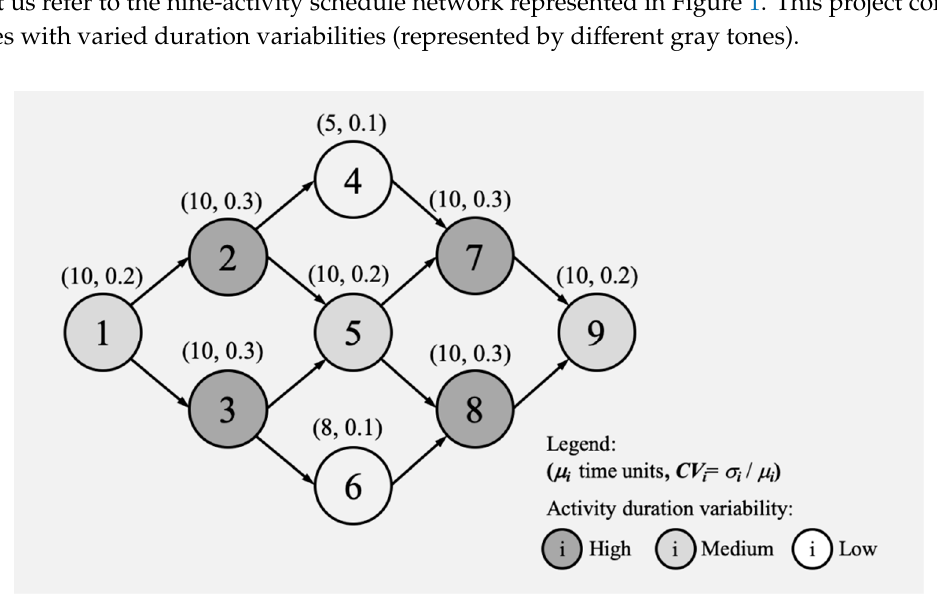
Figure 1. Example project schedule.